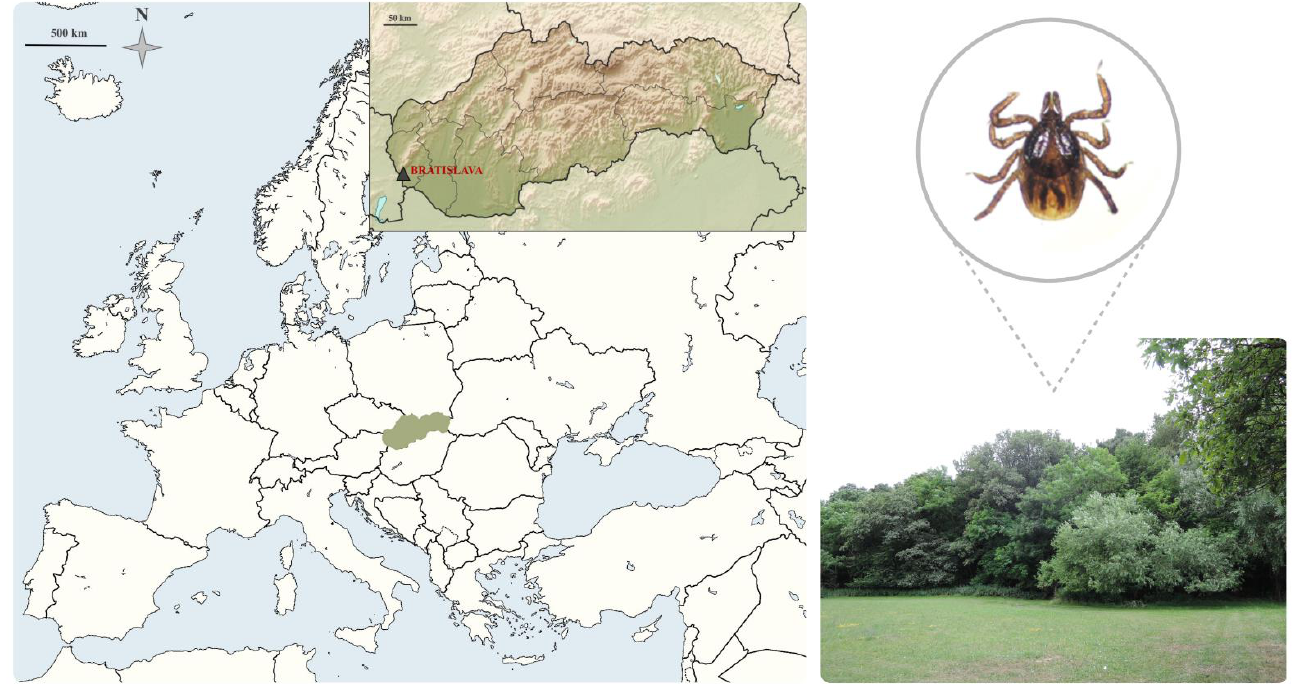
Figure 1. Tick sampling location in Slovakia. On the left: a political map of Europe indicating the location of Slovakia (in light green). Ticks were collected in the Bratislava district (marked with a triangle) by flagging method (maps from www.vidiani.com, accessed on 27 January 2022, licensed under CC-BY 3.0, desaturated from the original). On the right: I. ricinus nymph collected from the local vegetation (SMZ1500 Stereomicroscope).